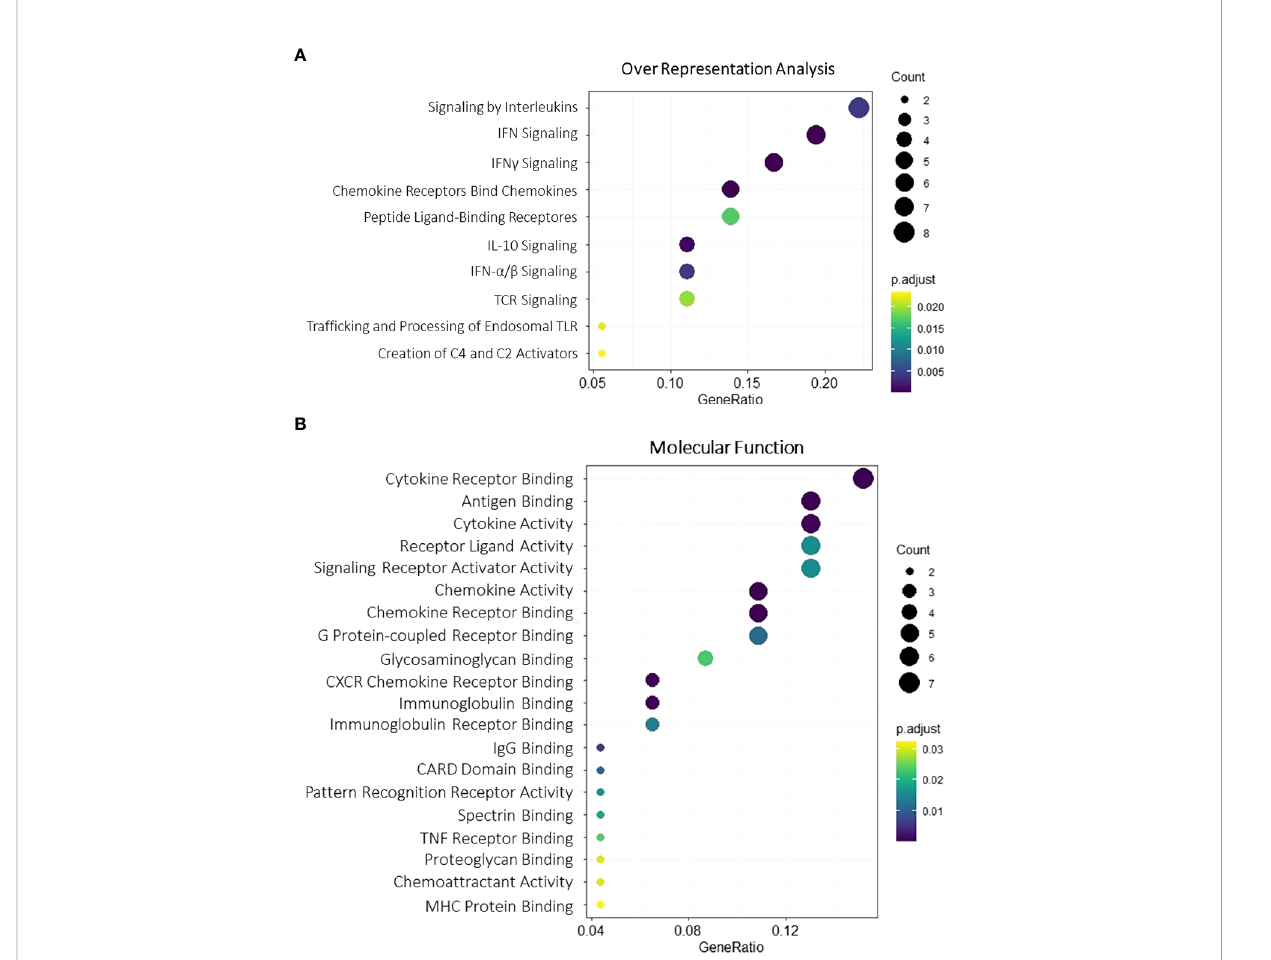
FIGURE 2 Gene Ontology enrichment for overlapping upregulated DEGs. Molecular function (A) and overall representation (B) for the 52 overlapping upregulated genes. Dot size is proportional to gene count, and color gradients follow adjusted p-value range, assuming higher signi fi cance for darker tones and lower signi fi cance for light ones. All terms were fi ltered for adjusted p-value < 0.05. DEGs, differentially expressed